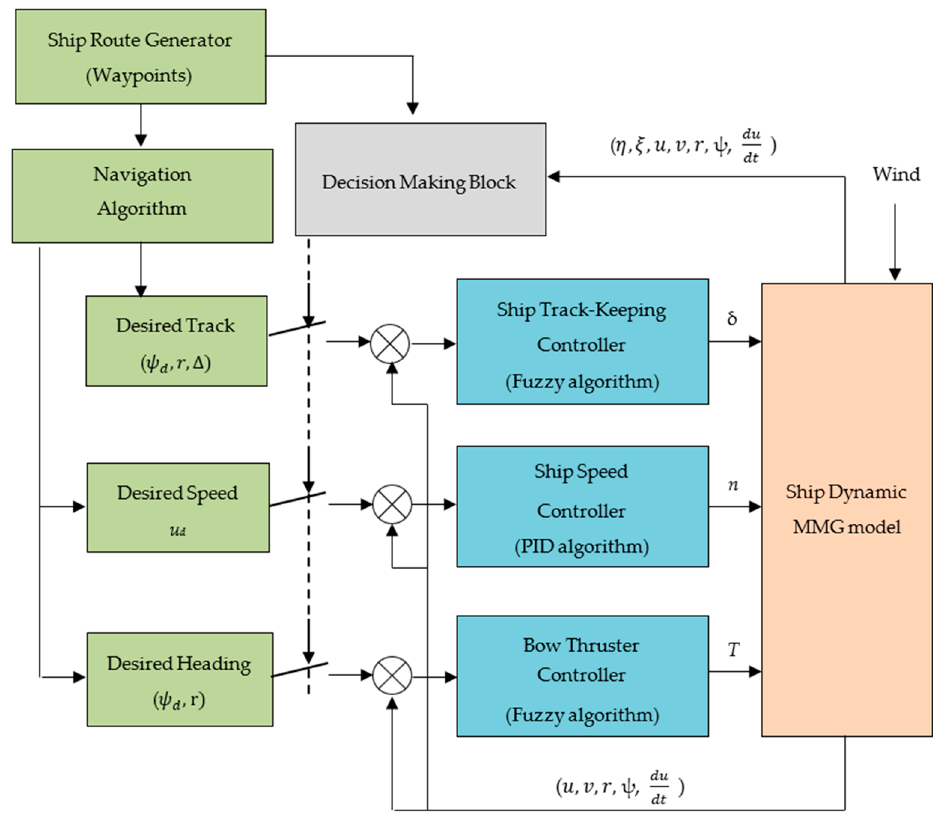
Figure 3. The operational area of the automatic navigation system.